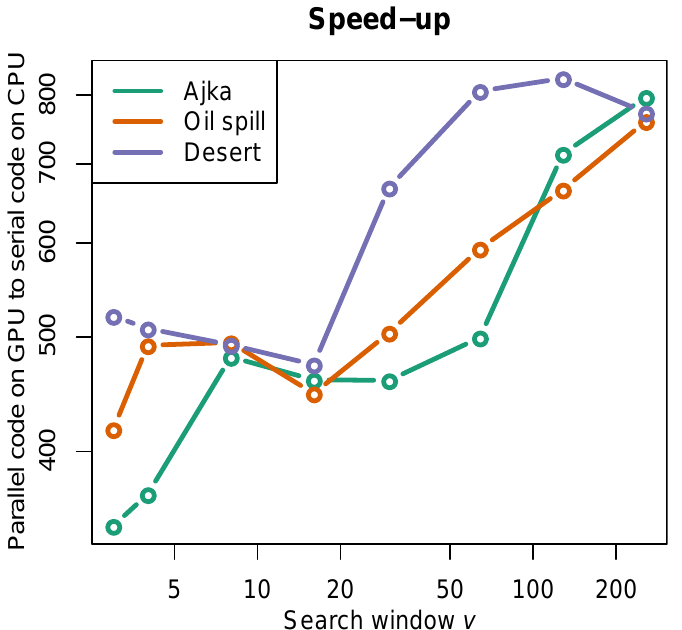
Figure 6. Plot speed-up of the parallel code on the GPU architecture with respect to the serial code on the CPU vs. search window v (similarity window d = 1) for images Oil Spill, Desert,